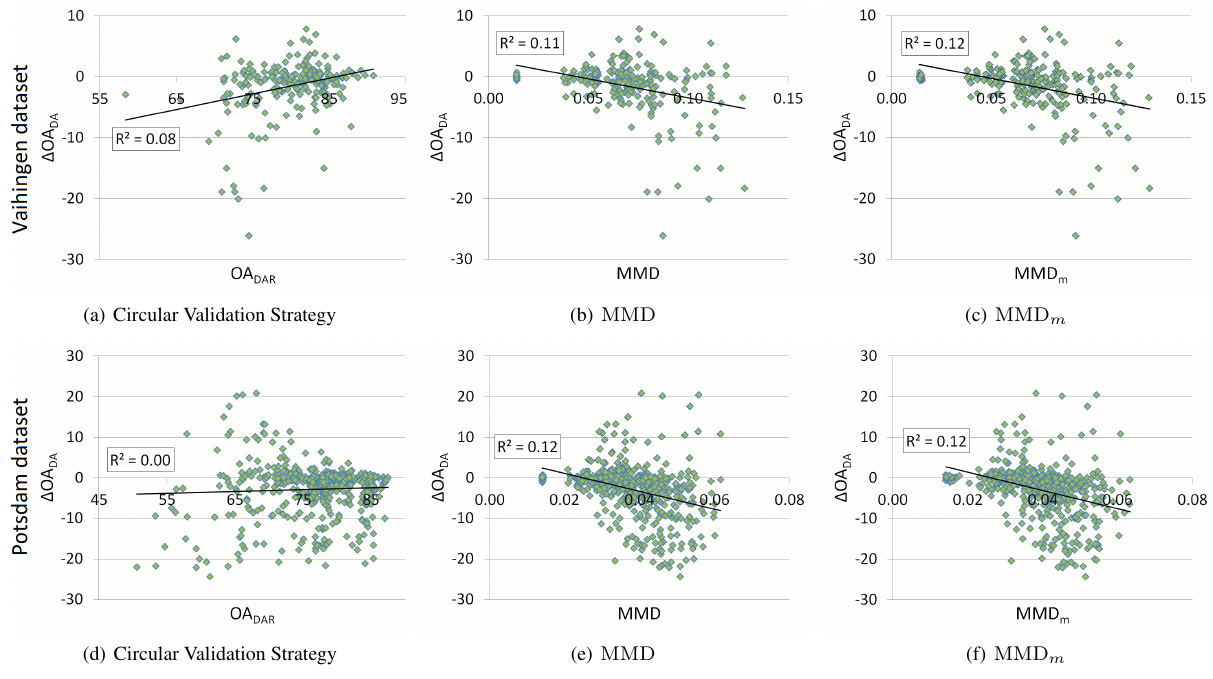
Figure 3: Results of regression analysis for the Vaihingen dataset (a)-(c) and Potsdam the dataset (d)-(f).